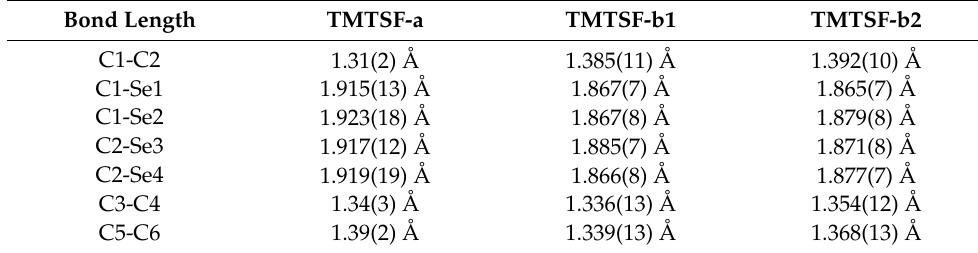
Table 1. Intramolecular bond length of TMTSF-a and TMTSF-b molecule in compound 1 .